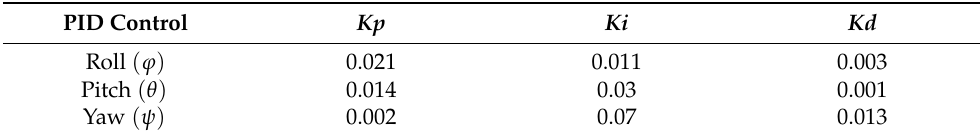
Table 1. Control gain values of the inner-loop PID controllers. PID